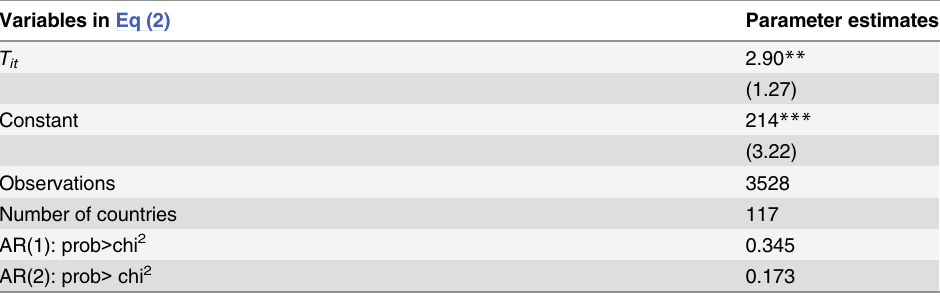
Table 3. Estimates in TFP